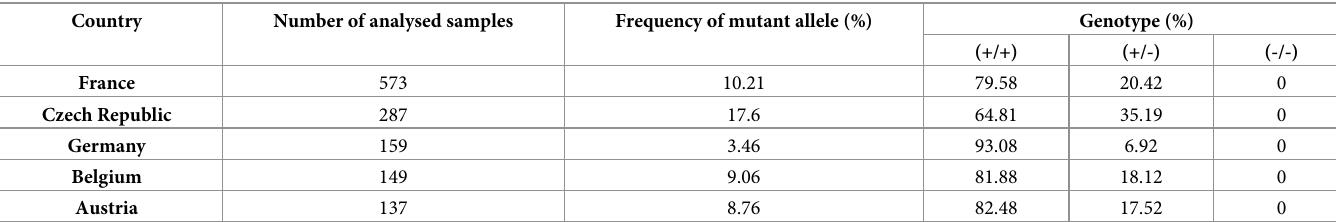
Table 6. Comparison of genotype and mutant allele frequencies in the top five countries for HC disease. Country